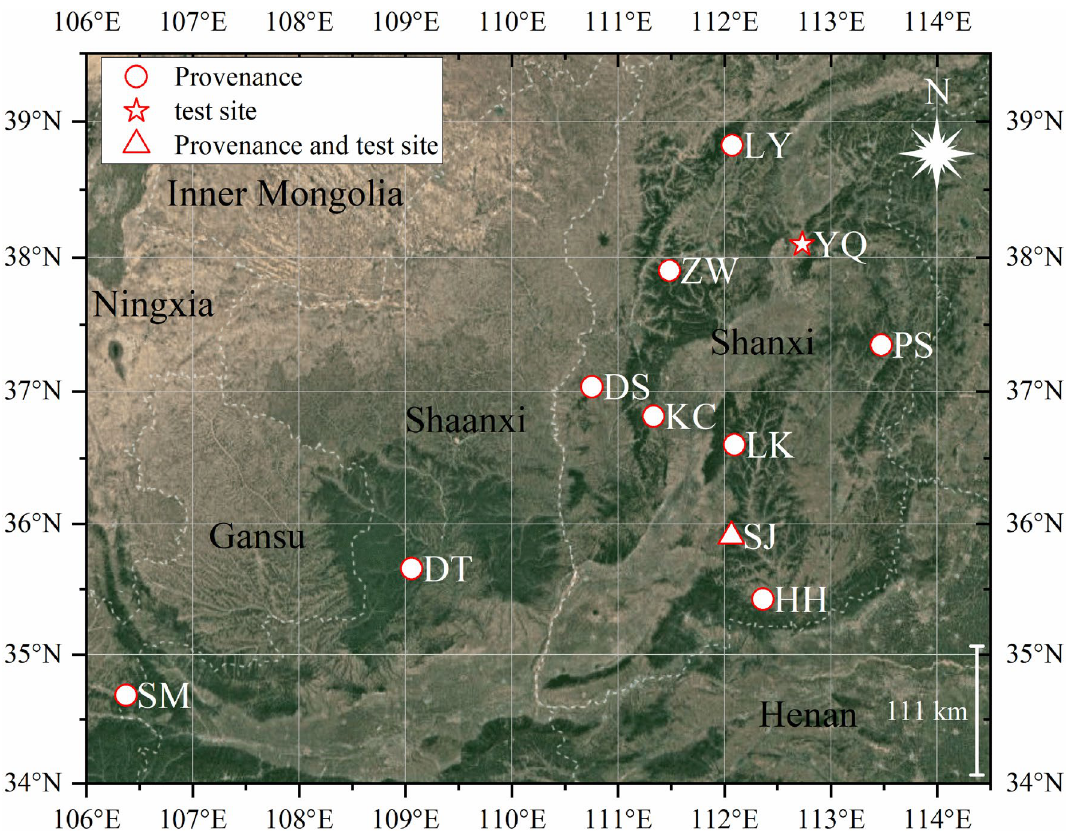
Figure 1. Geographical locations of Quercus liaotungensis provenances and test sites. The map is created using the Google Map Import plug-in of Origin 2018 (https:// www. origi nlab. com/ fileE xchan ge/ detai ls. aspx? fid= 344). Coordinate reference system is WGS-84. PS Pingsong provenance, LY Luyashan provenance, KC Kangcheng provenance, HH Henghe provenance, LK Lingkongshan provenance, DS Dongshan provenance, SJ Sanjiao provenance (and Sanjiao test site), SM Shanmen provenance, ZW Zhenwushan provenance, DT Diantou provenance, YQ Yangqu test site.